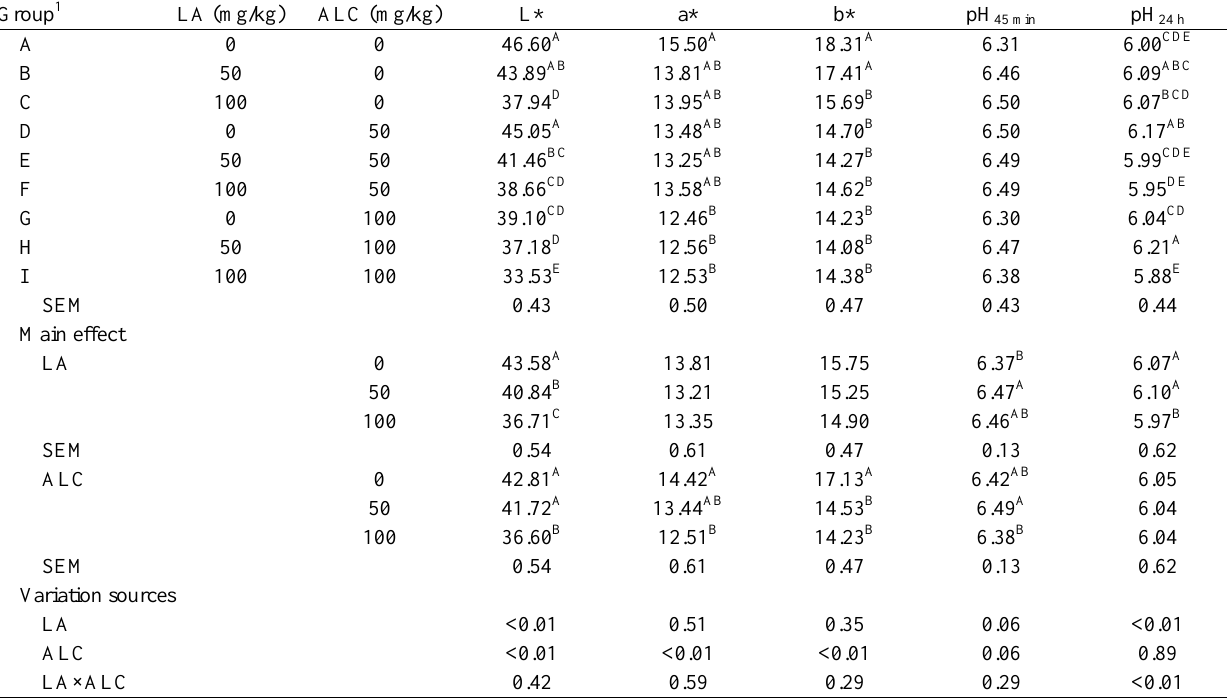
Table 4. Effects of dietary LA and ALC on the breast muscle meat quality of broilers Group 1